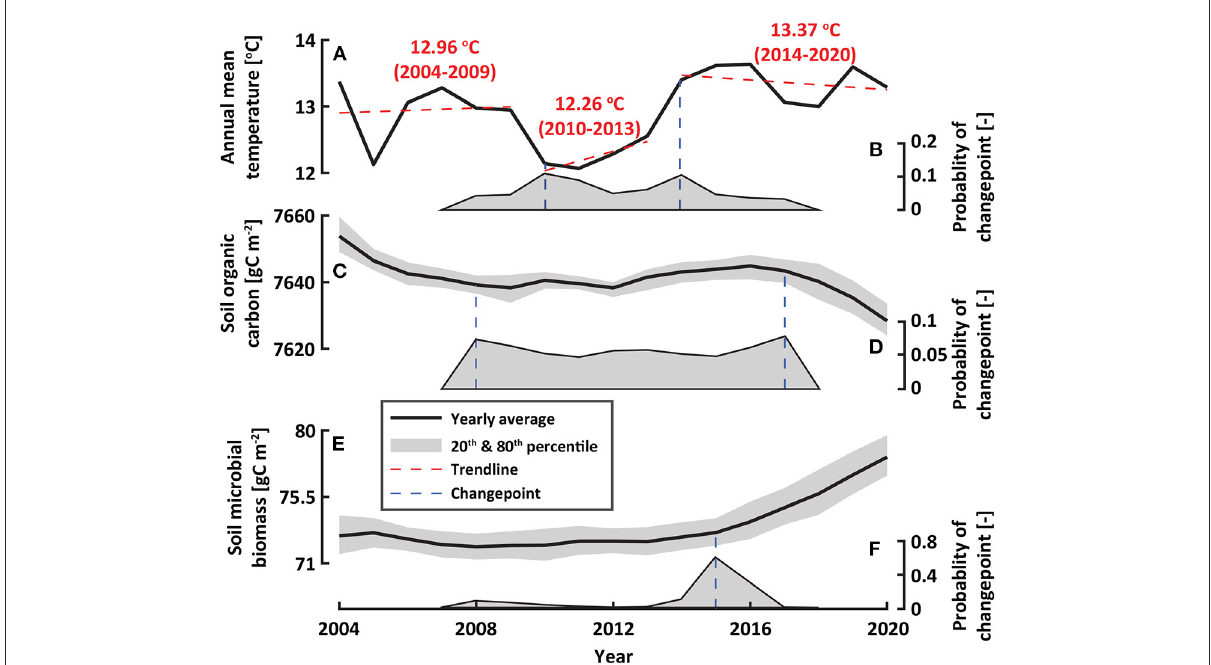
FIGURE4 The impacts of temperature rise on soil organic carbon and microbial biomass. (A) Observed annual mean temperature and (B) its probabilities of trend changepoints, (C) modeled soil organic carbon, (D) its probabilities of trend changepoints, (E) modeled soil microbial biomass, and (F) its probabilities of trend changepoints during the study period. The shaded gray areas in (C,E) indicate the 20th and 80th percentiles that represent their variations in a given year. Red in (A) and blue (B,D,F) dotted lines represent linear trend lines and changepoints,